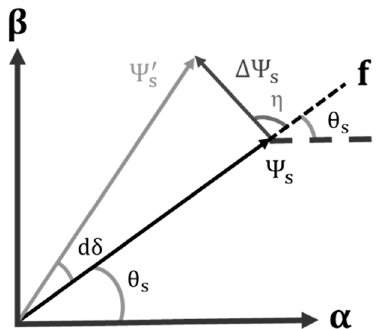
Figure 3. The flux linkage vector in 𝛼 - 𝛽 frame.